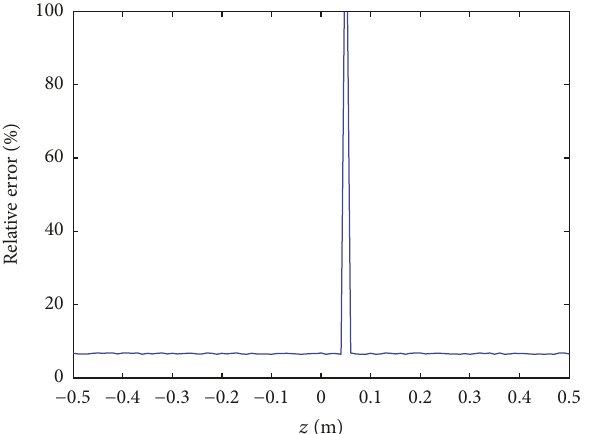
Figure 11: Reconstruction errors for different positions of the additional fictitious source at 500 Hz.